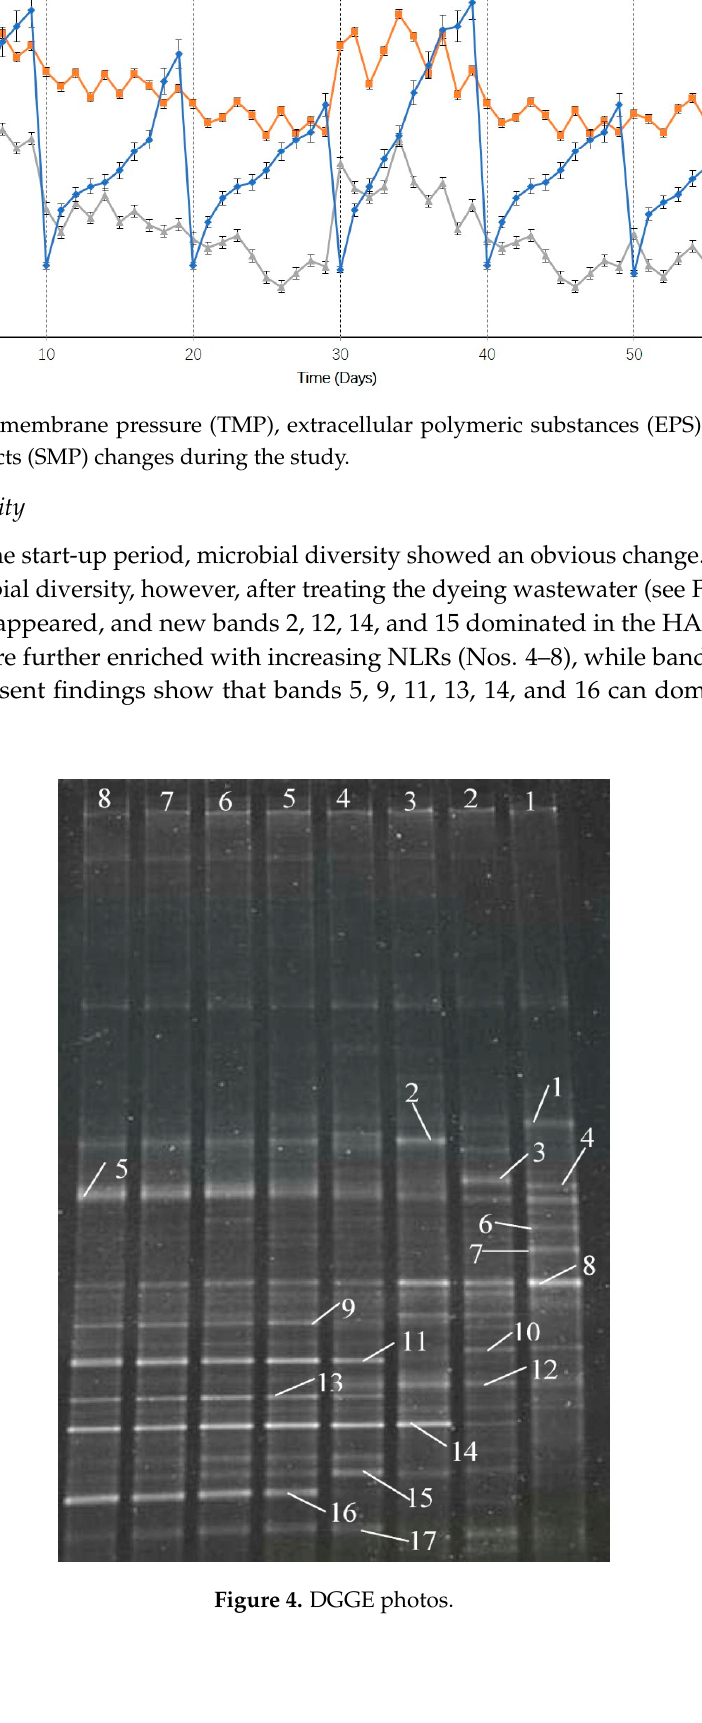
5 of 11 Figure 2. Color changes during the study (left: Influent; middle: Treated by anaerobic microorganisms; right: Filtrate). 3.2. Membrane Fouling During the study, the membrane flux was set at 5 L/m 2 /h. As mentioned previously, the test was divided into six stages. At the end of each phase, the flat-sheet ceramic membranes were chemically cleaned by pumping 1000 mg/L NaOCl into the inner space of the membranes. The membranes were soaked for 1–2 h to recover filtration performance.